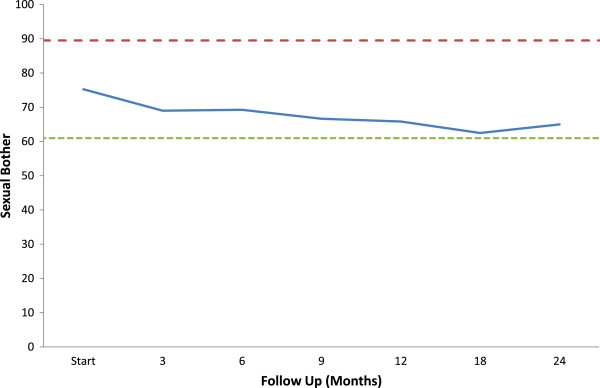
EPIC sexual bother at baseline and following SBRT for prostate cancer- Question 12 of the EPIC-26. Average sexual bother scores. Thresholds for clinically significant changes in scores (½ standard deviation above and below the baseline) are marked with dashed lines. EPIC scores range from 0–100 with higher values representing a more favorable health-related QOL.